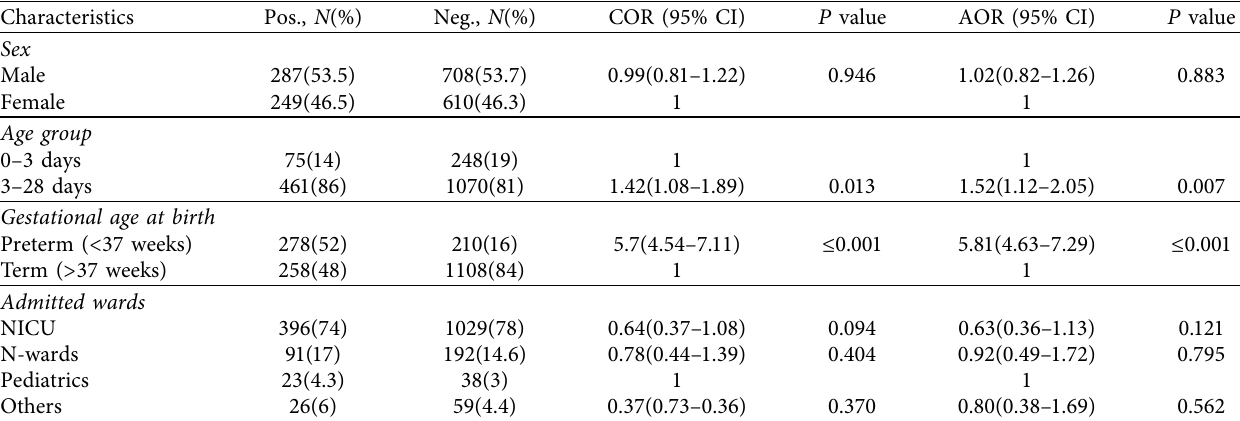
Table 3: Bivariate and multivariate analysis relationship between risk factors and bacterial isolates among neonates having sepsis at University of Gondar Comprehensive Specialized Referral Hospital, Gondar, Northwest Ethiopia, 2021.